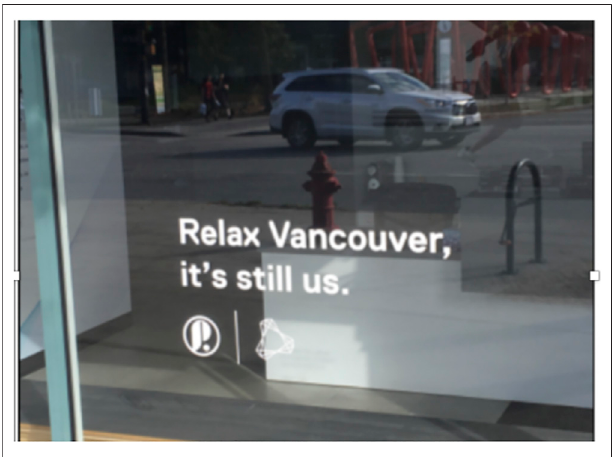
FIGURE 10 | Relax, Vancouver